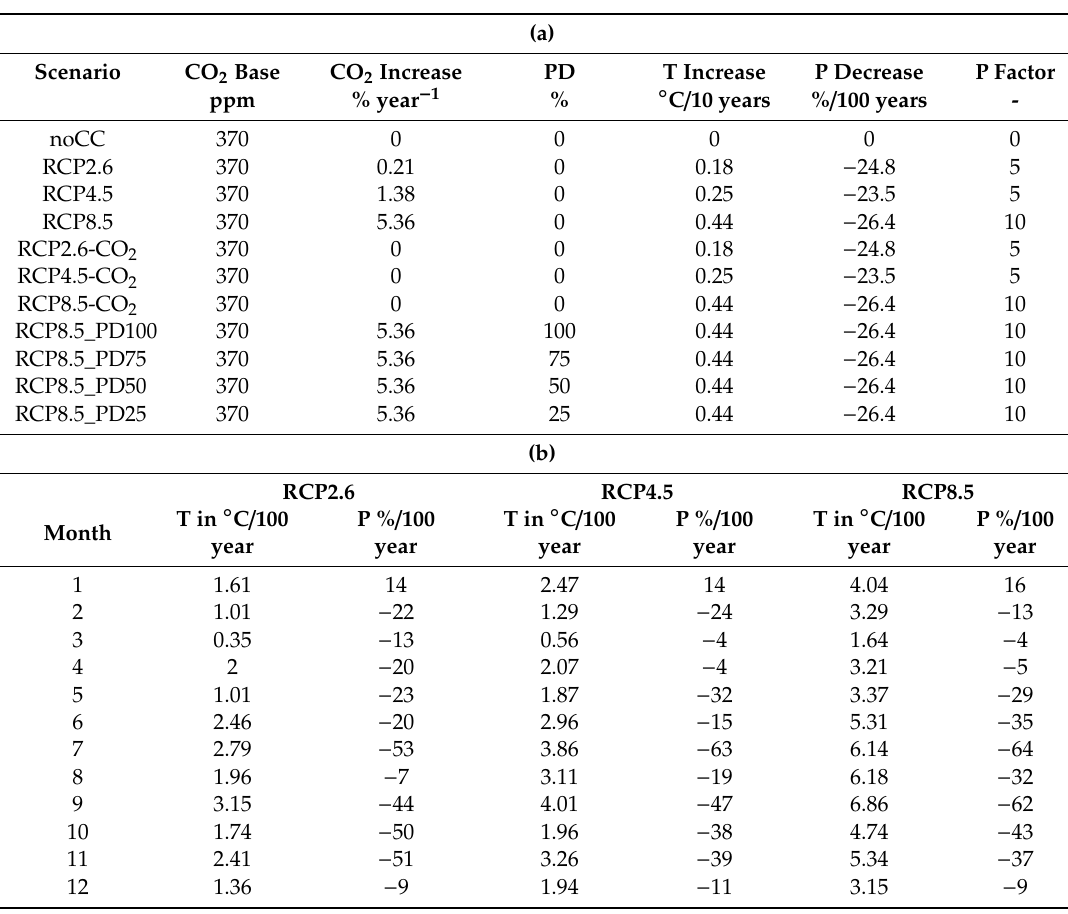
Table2. Definitionsof10climatechangescenarioswith(a)basevalueforatmosphericCO 2 concentration (CO 2 Base), CO 2 increase in % year − 1 , downregulation factor of photosynthesis (PD), increment of temperature (T increase), decrement of precipitation (P decrease) and concentration factor inducing more intense precipitation events (P factor). In (b), monthly factors of temperature increase (T in ◦ C / 100 year) and precipitation decrease (P % / 100 year) are listed. Coordinates from the Freiamt site were used to get the data from the MPI-ESM-LR global circulation model from the WorldClim database (http: // www.worldclim.org /